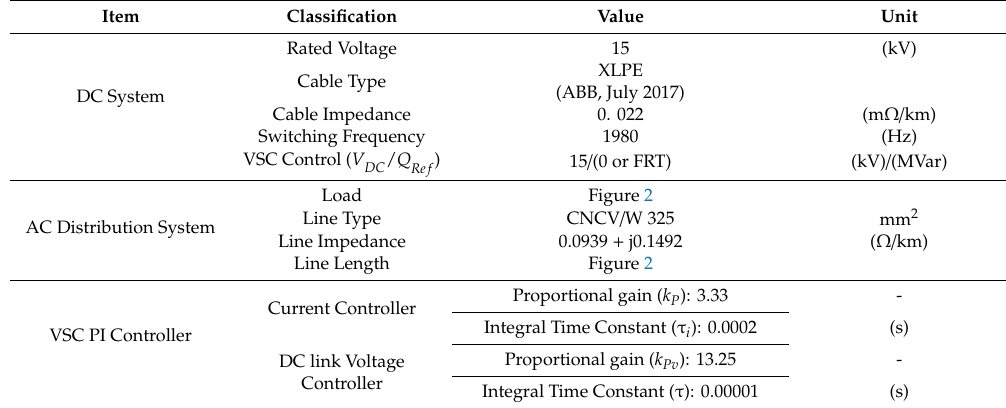
Table 4. Parameters for Simulation in whole System.